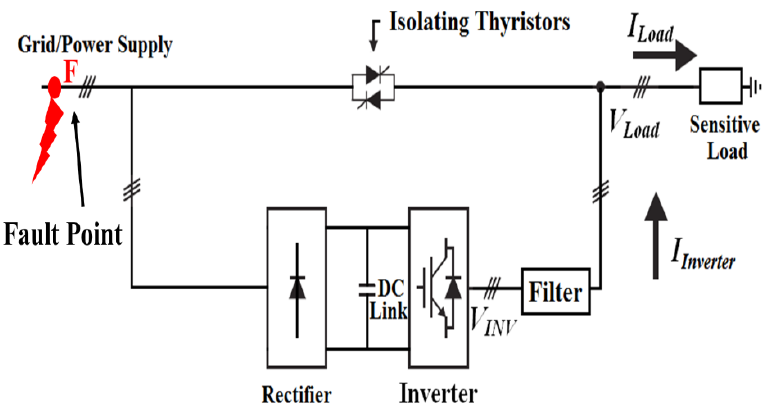
Figure 2. Simple diagram of the proposed asymmetrical fault correction technique for sensitive loads.